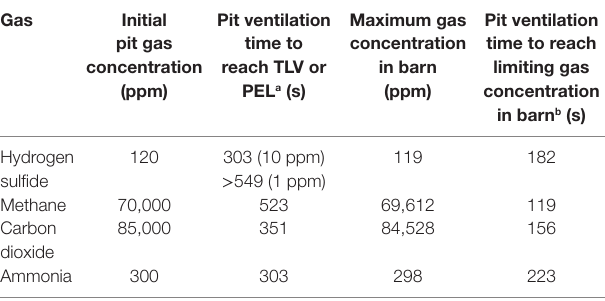
TABle 2 | case 2 simulation results for hydrogen sulfide, methane, carbon dioxide, and ammonia: slotted-covered manure pit beneath cross-ventilated barn.